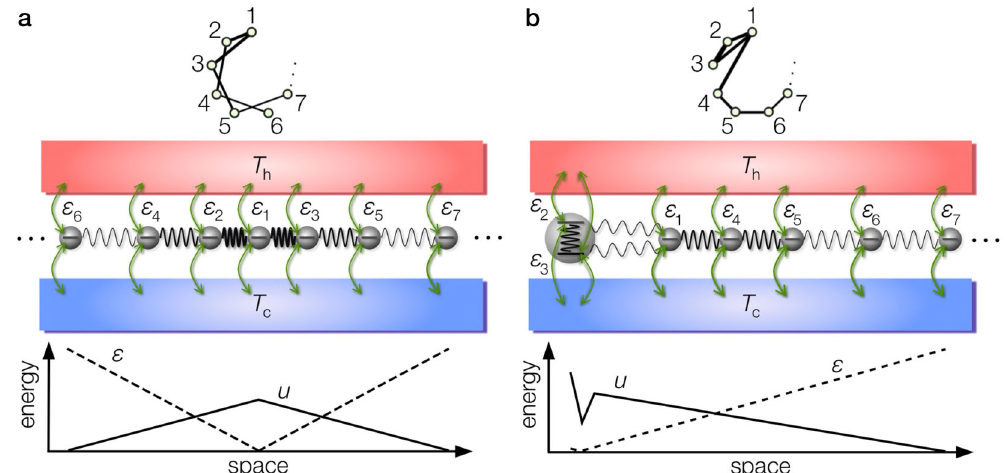
Fig. 6 Designing the highest-power nanoscale heat engines with quantum dot arrays. Illustrations of speci fi c array con fi gurations that can achieve the maximum-power heat engines. The single-electron energies are assumed to be equally spaced, i.e., ϵ l = l Δ with Δ being energy spacing. a Each quantum dot (gray circles) has a single level and exchanges electrons (green arrows) with reservoirs at temperatures T h,c (where h stands for hot, the red reservoir, and c stands for cold, the blue reservoir). Quantum dots are linearly aligned from the center in order of increasing energies ϵ l with l = 1, 2, … , . Distances are controlled in such a way that nearest-neighbor interactions represented by u (wavy lines) progressively weaken with the distance from the center. The corresponding network topology of the interaction is also shown. b The leftmost dot has two levels, while the other dots have a single level and are linearly aligned in order of increasing energies. Distances are controlled in such a way that the interdot (nearest-neighbor) interaction between two leftmost dots is weak, while the other interactions progressively weaken as distance from the left. The corresponding network topology of the interaction is also